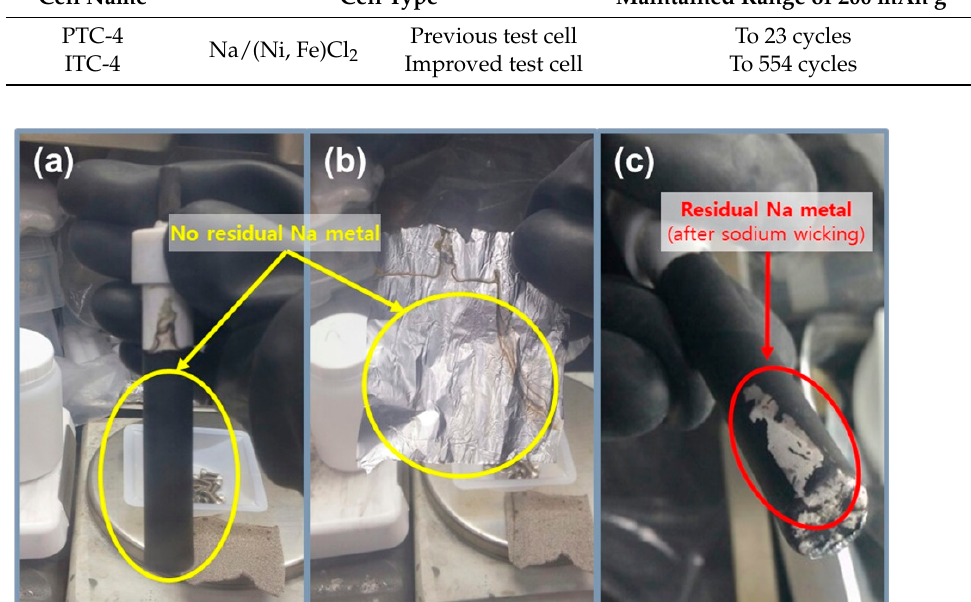
Figure 5. Photos of the previous test cell after cycling test, ( a , b ) no residual sodium metal on the BASE surface and Al foil; ( c ) the residual sodium metal (red circle) on the BASE surface after cycling test due to the capillary effect in the vertical wrinkles of the Al foil.